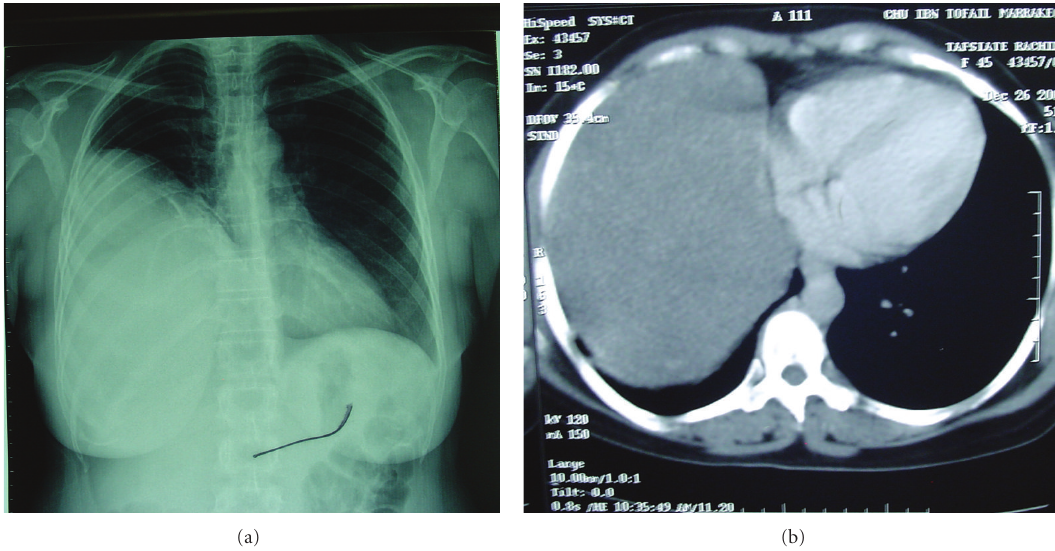
Figure 1: (a) Initial chest radiography showed right basithoracic mass with clear limits and obtuse connection angles. (b) Initial computed tomogram with contrast revealed one mild homogeneous, well-defined mass that compressed the mediastinum to left side.